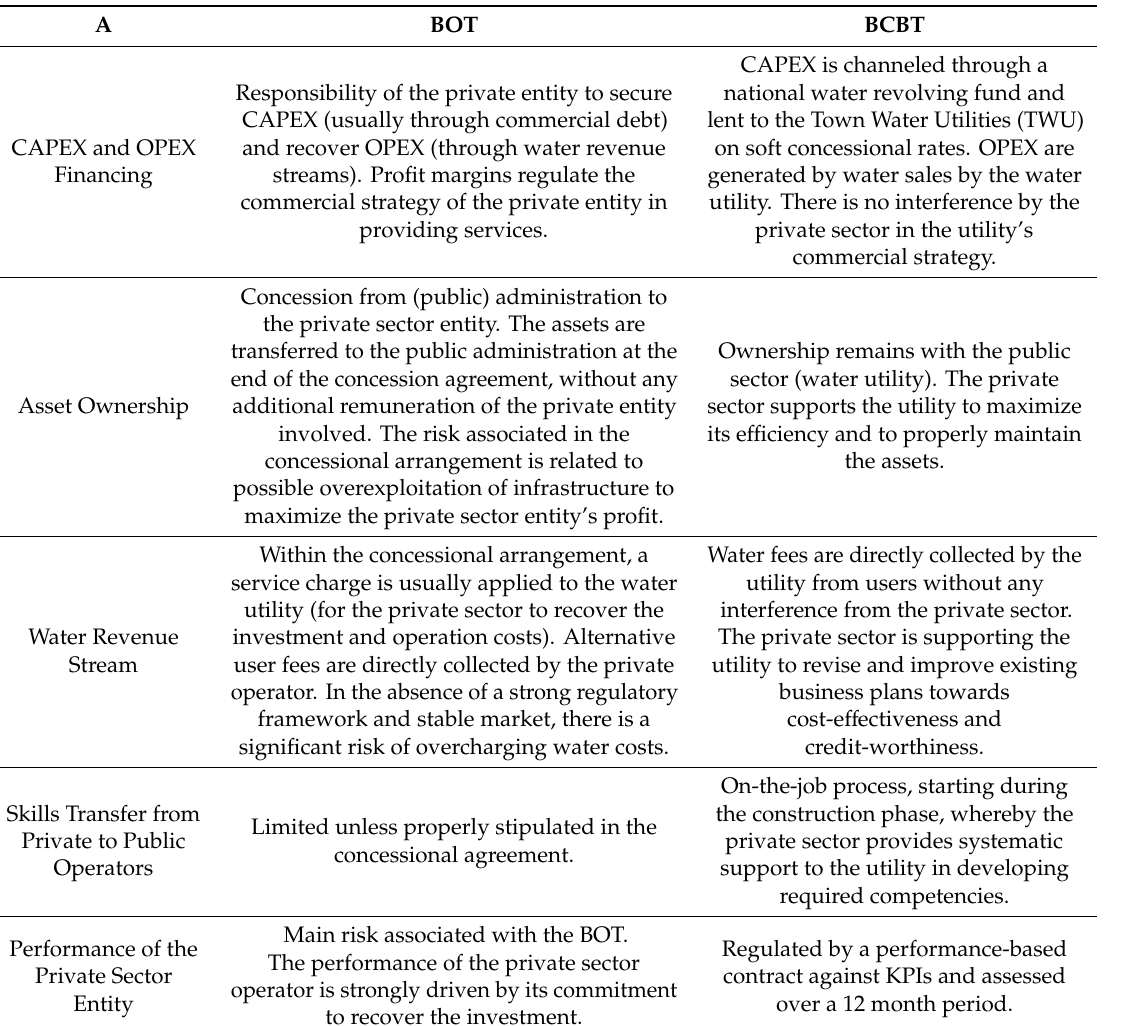
Table 1. Comparison of the build, capacity build and transfer (B-CB-T) and the build, operate and transfer